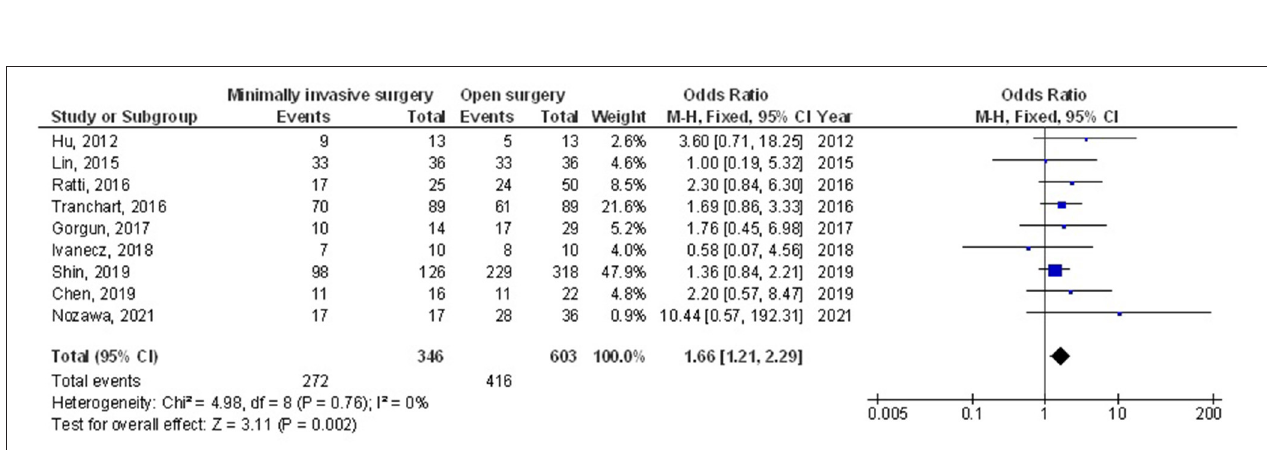
Frontiers in Surgery |